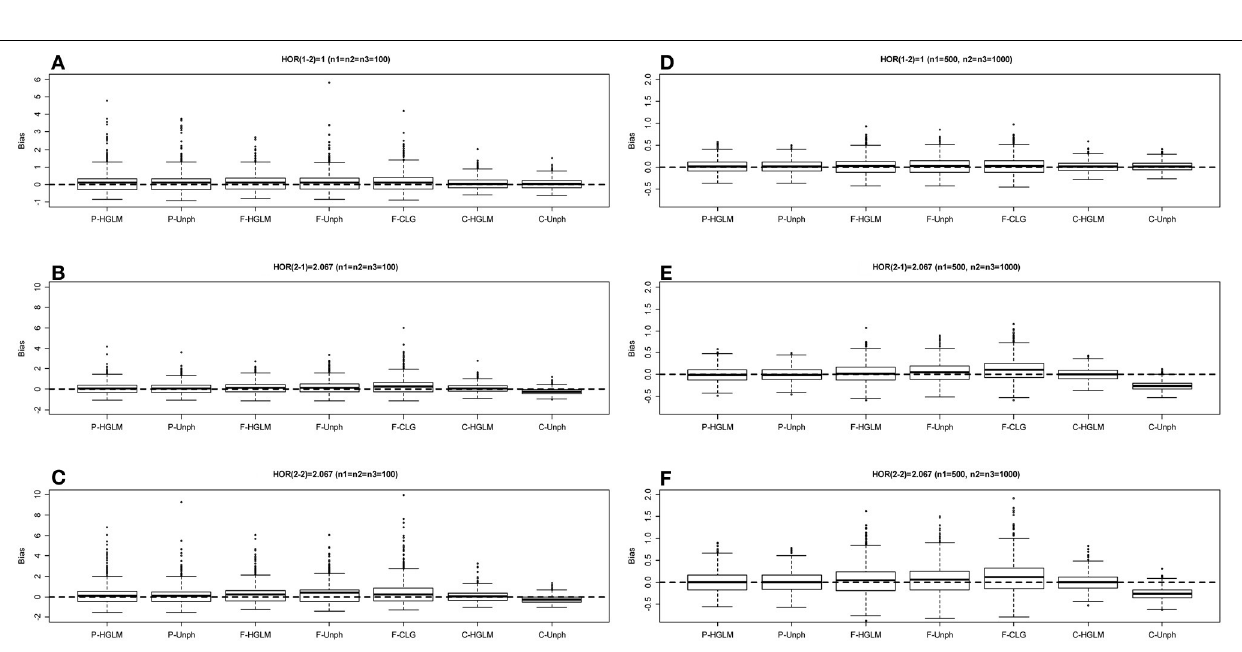
sample size increases, the proposed ANOVA and Unph lead to larger power. When there is PS, the overall test (i.e., MANOVA) and haplotype-specific test (i.e., ANOVA) for appropriateness of combined data perform better than Unph in terms of larger